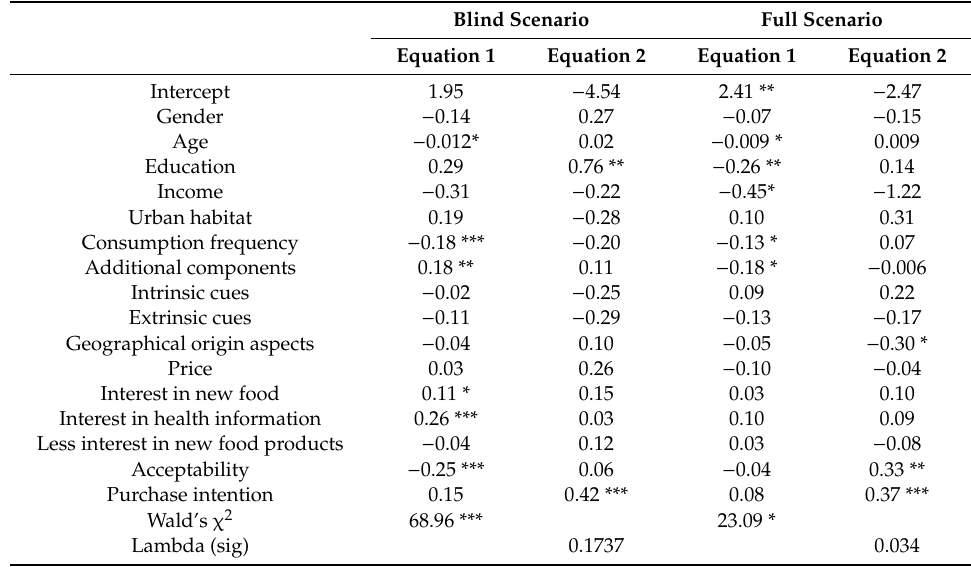
Table 6. Heckman models of the influence of sociodemographic factors, consumption frequency, pre-purchase quality cues, overall general acceptability, and purchase intention on willingness to pay for patties by information